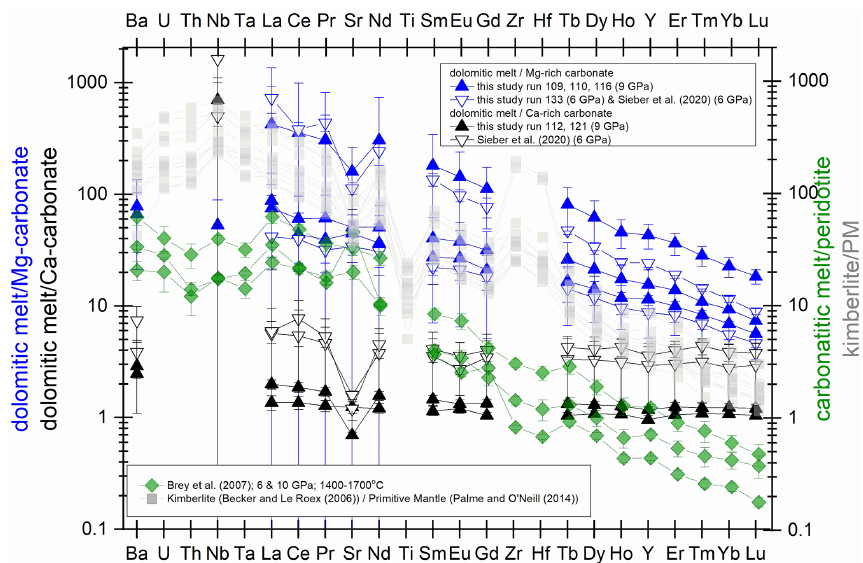
Figure 7. Trace element signature in the pure carbonate system (blue: Mg-rich composition; black: Ca-rich composition) compared to carbonatitic melt/peridotite (Brey et al., 2007) and Group-I kimberlites (Becker and Le Roex, 2006) normalized to the primitive mantle (Palme and O’Neill, 2014). Note that the strong fractionation of heavy to light REEs of primitive kimberlitic melts can be approached by our melting experiments at 9GPa and at 6GPa with Ca-magnesite and dolomitic melt.